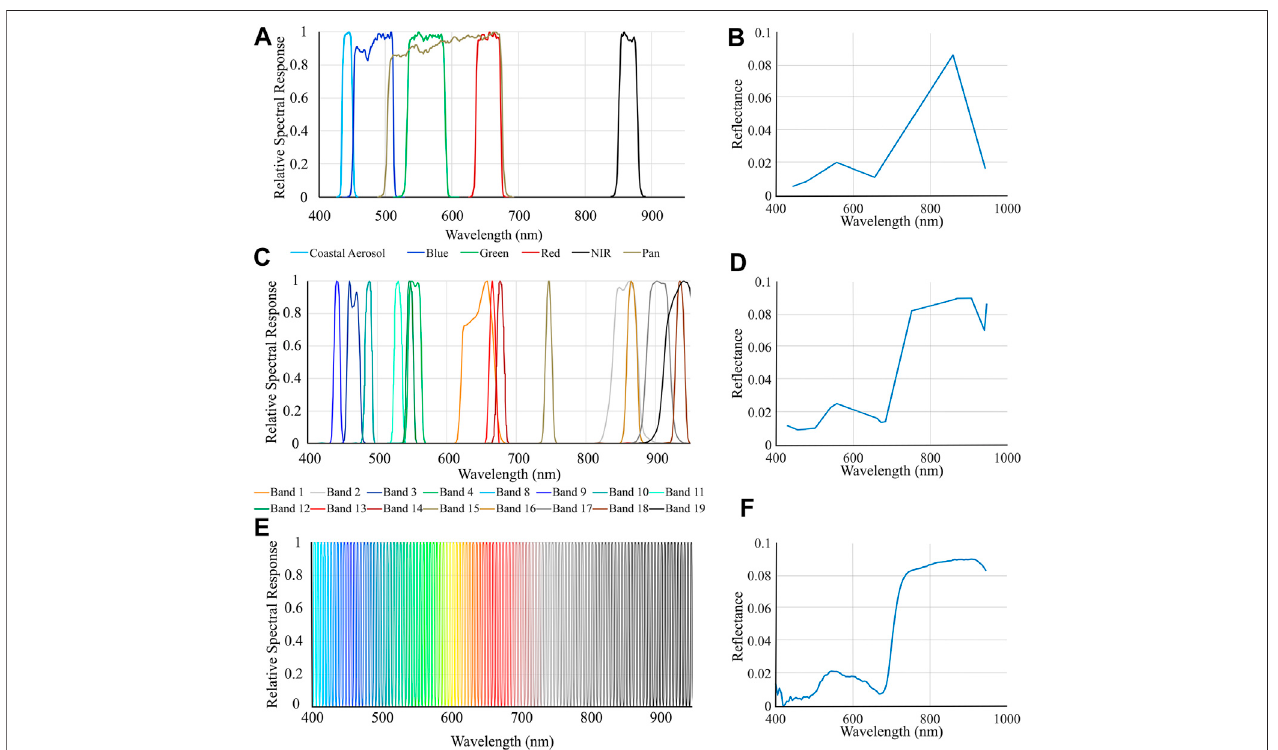
FIGURE 5 | Relative Spectral Response (RSR) functions of two satellite sensors and the airborne sensor resampled to in this work for the 400 – 950 nm spectral range, and an example of a Vallisneria americana spectrum obtained after each spectral resampling. (A) RSR of the Landsat 8OLI sensor. (B) V. americana spectrum resampled to Landsat 8OLI. (C) MODIS ’ s RSR. (D) V. americana spectrum resampled to MODIS. (E) RSR of the CASI airborne hyperspectral imager. (F) V. americana spectrum resampled to the